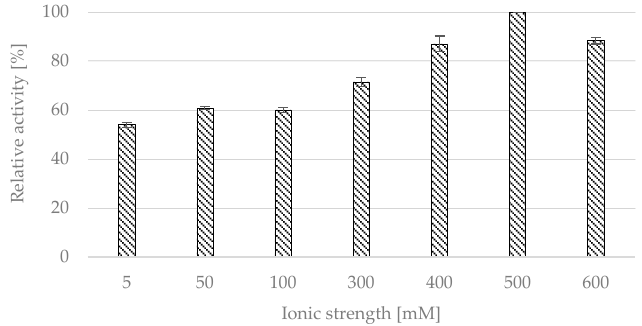
Figure 2. Effect of buffer ionic strength on the activity of immobilized CALB. Reaction conditions: immobilized CALB onto Octyl-Sepharose CL-4B (50 mg), phosphate buffer (100 mM, pH 7.4), the emulsion of gum Arabic and olive oil, temperature 37 °C, incubation 30 min. Data are presented as means ± standard deviations of three analyses ( n = 3). The error bars represent the standard deviations of the mean.